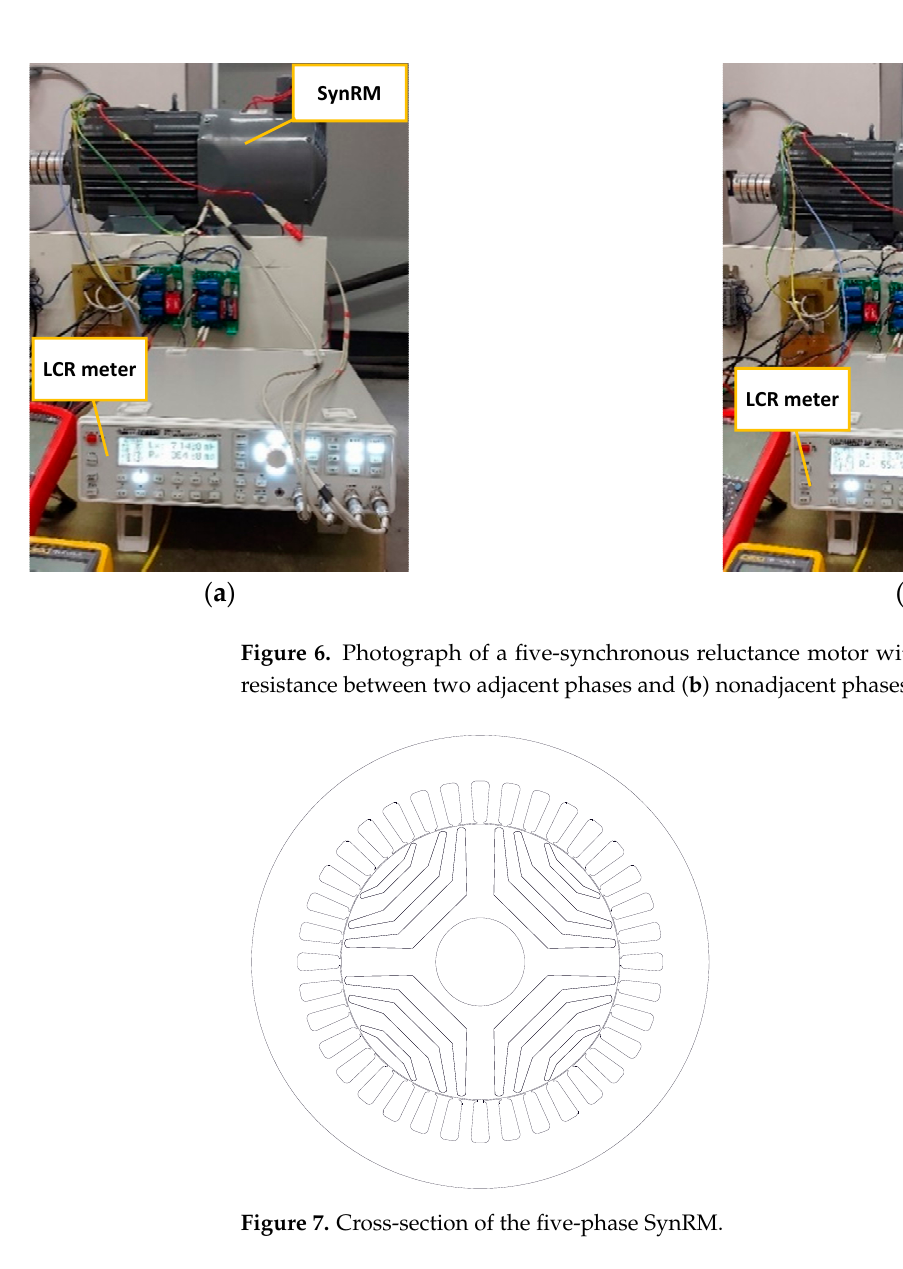
Table 3. The obtained sequence of phases.